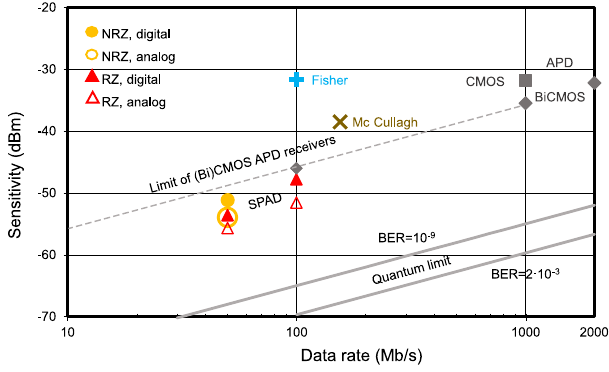
Figure 6. Comparison of sensitivities for receiver OEICs and quantum